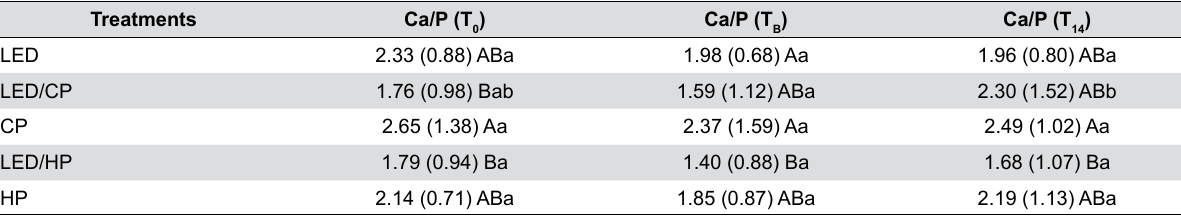
Table 5- Mean values and standard deviations of the Ca/P ratio according to treatments and evaluation